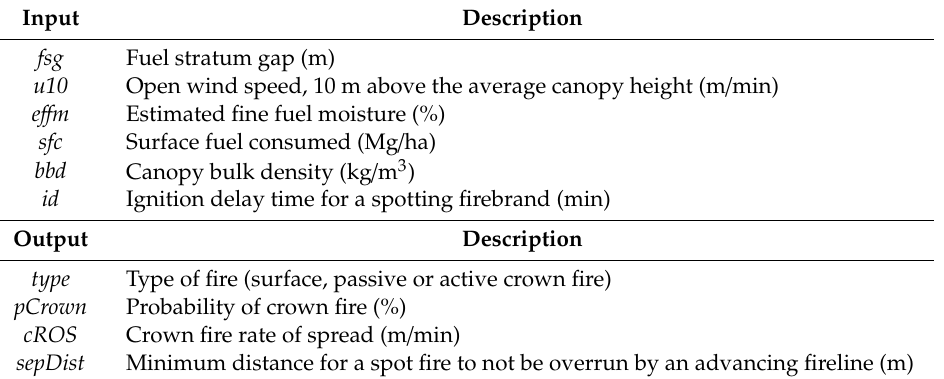
Table 2. Inputs and outputs for the cfis() function 1